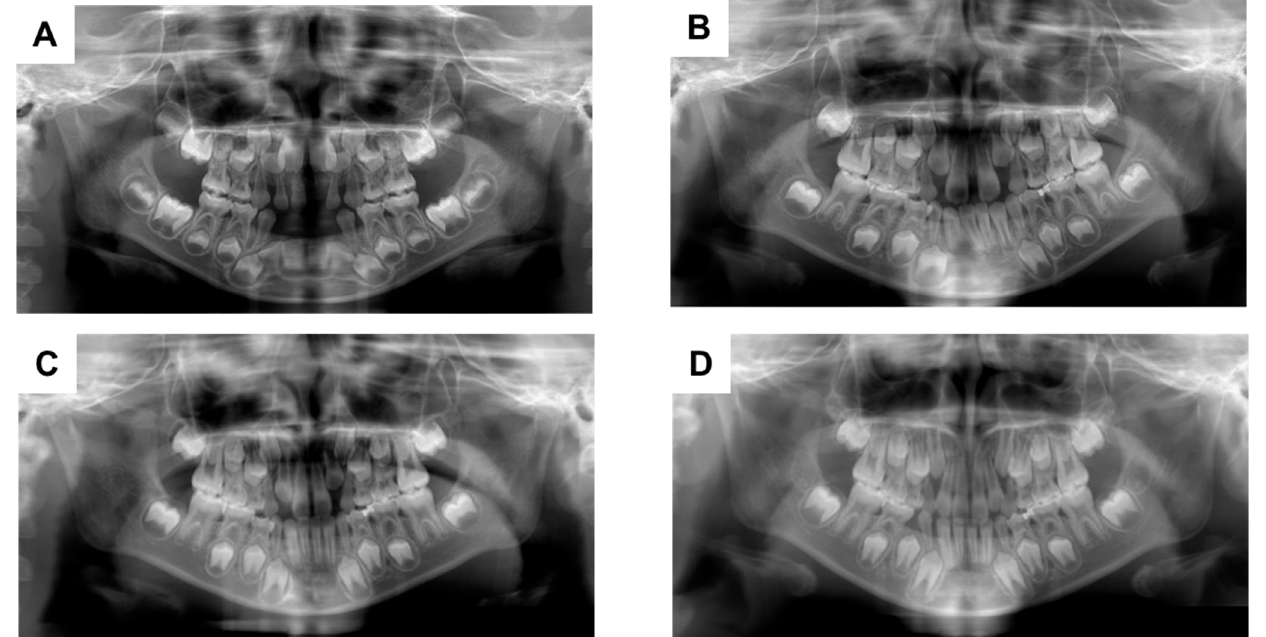
Figure 1. Orthopantomographs taken during follow-up. When the patient was aged ( A ) 5 years and 10 months; ( B ) 8 years and 3 months; ( C ) 9 years; and ( D ) 10 years and 1 month.